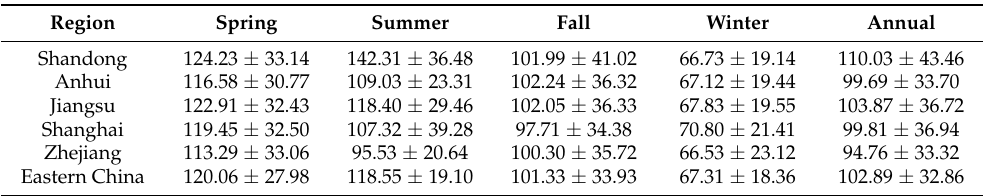
Table 2. Seasonal and annual averages ± deviations of population-weighted MDA8 O 3 for five provinces and the all of eastern China in 2020 ( µ g m − 3